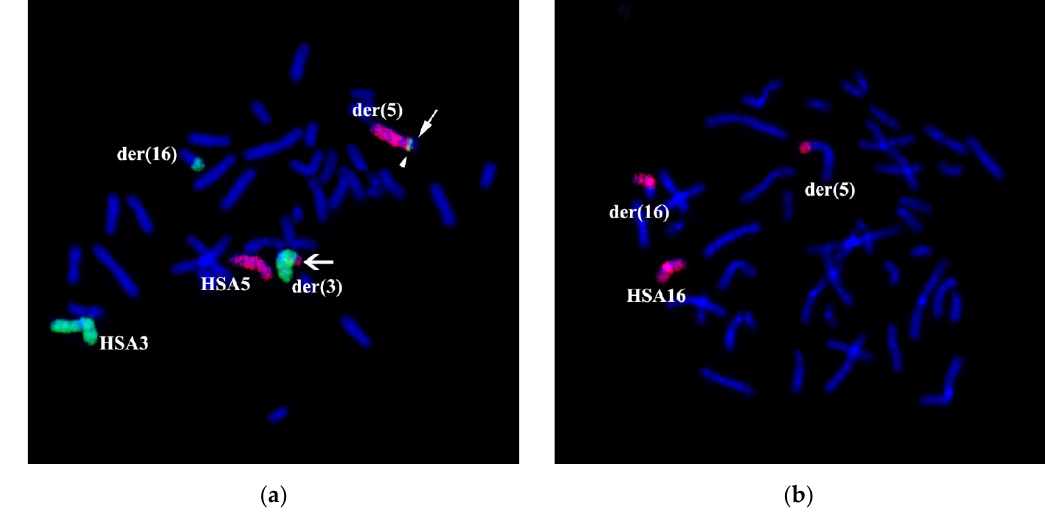
Figure 3. Chromosome painting of patient’s chromosomes. Two-color CISS hybridization on the patient’s metaphase chromosomes with DNA probes WCP3 (green)/WCP5 (red) ( a ) and WCP16 (red, ( b )). DAPI staining is in blue. Intact complete chromosomes are indicated as HSA3, HSA5, and HSA16. ( a ) → —arrow shows the absence of a signal on the short arm of the chromosome 5 derivative. ▶ —arrowhead indicates the WCP3 signal (green) on the short arm of the chromosome 5 derivative. ➔ —arrow indicates WCP5 (red) signal at the distal region of the long arm of chromosome 3. ( a ) Chromosome 3 material was detected on chromosomes der(5) and der(16). ( b ) Chromosome 16 material was detected on the short arm of chromosome der(5).